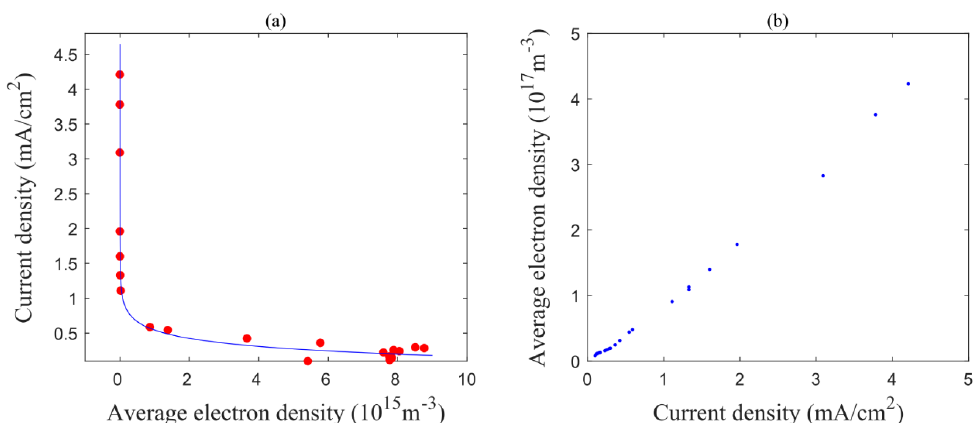
Figure 6. The relationship between the average electron density and discharge current density. ( a ) average electron density at the starting moment of the discharge vs. current density at the instant of current peak, ( b ) current density at the instant of current peak vs . maximum average electron density.